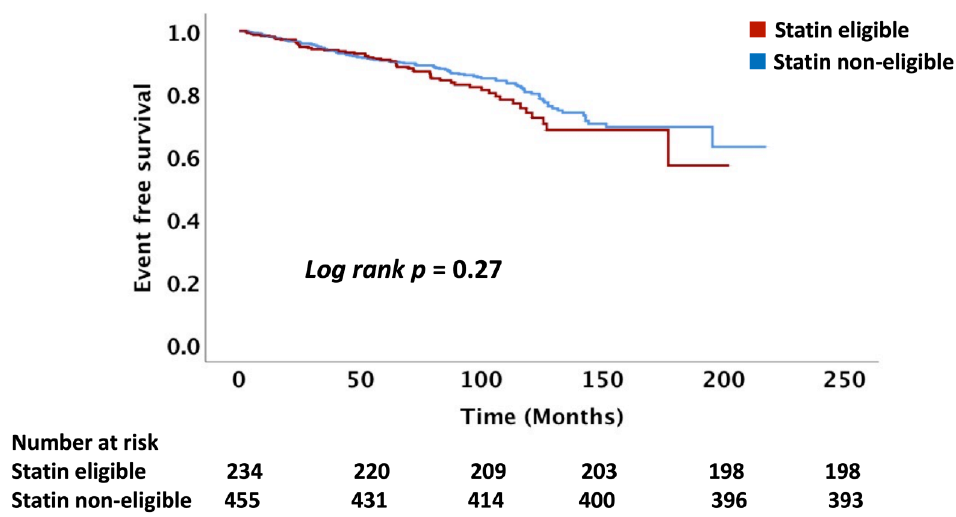
Figure 3. This figure demonstrates the Kaplan–Meier curves comparing the ASCVD events between the statin eligible vs. non-eligible groups based on the Framingham criteria. T0 = radiation therapy treatment. ASCVD = atherosclerotic cardiovascular disease. Table 5. Cox regression analysis, outcome—ASCVD